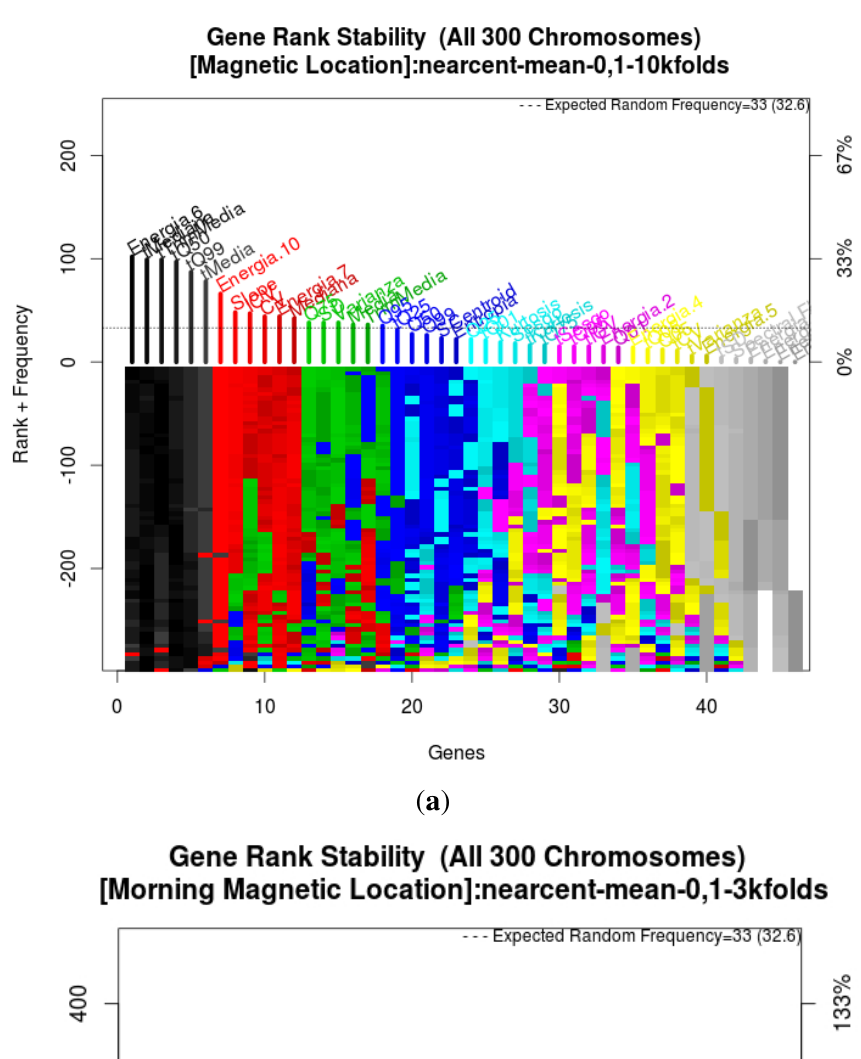
Figure 7. Feature ranking during GA; ( a ) residential home scenario; ( b ) office building